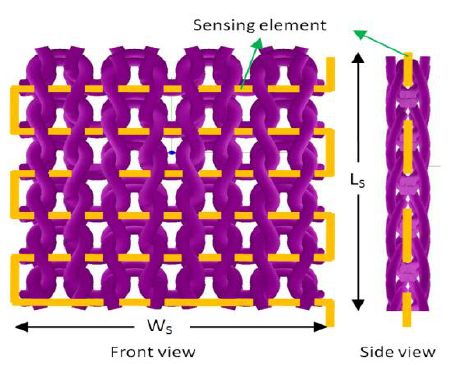
Figure 1. Concept of Temperature Sensing Fabric (TSF); sensing wire inlaid in a double layer knitted structure.